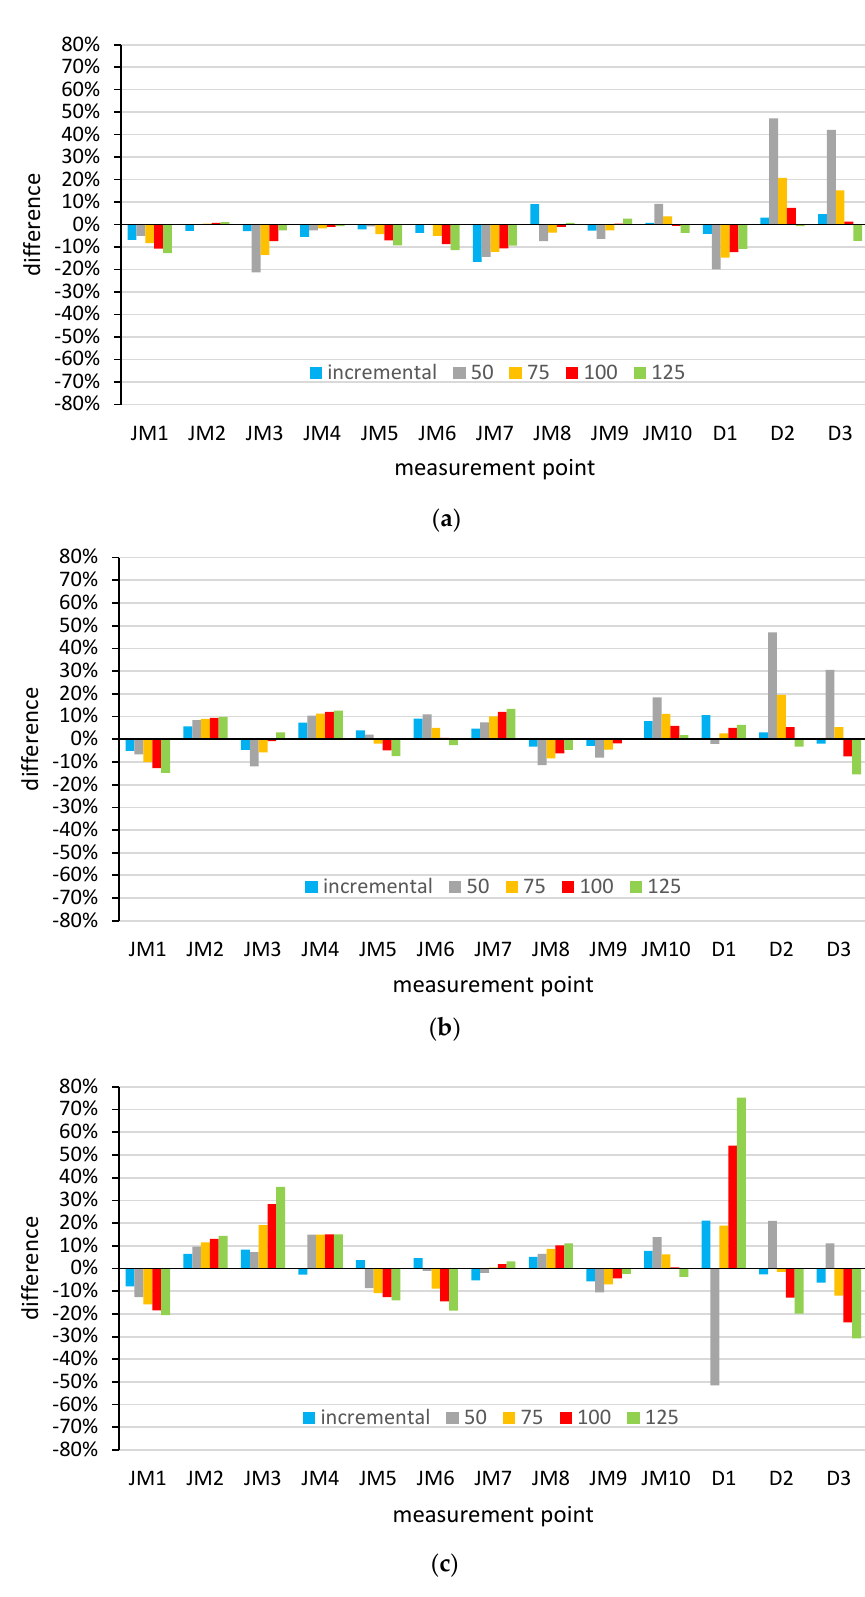
Figure 12. Difference comparison between predictions and experiments: ( a ) Experimental Case 1; ( b ) Experimental Case 2; ( c ) Experimental Case 3 (rotational stiffness in 10 3 kNm/rad).